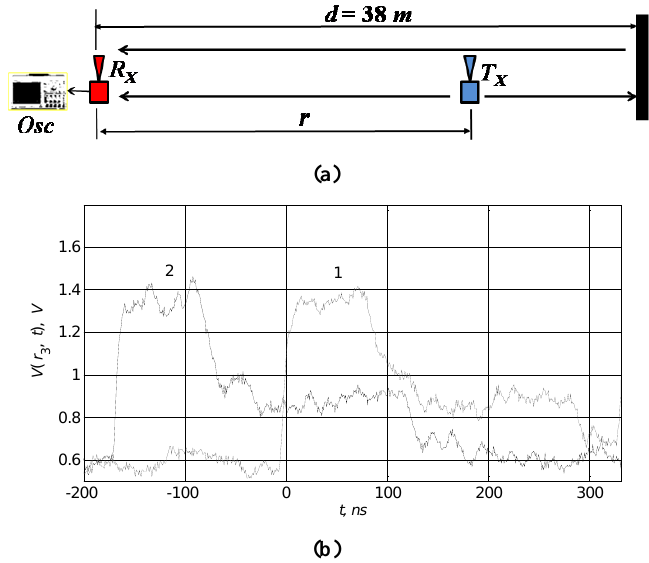
Fig. 1. Measurements of the propagation characteristics: (a) experimental layout. R X – receiver, T X – emitter, Osc – oscilloscope, d = 38 m , r is varied in the range 2 to 32 m; (b) envelopes of chaotic radio pulses V ( r 3 , t ) for r 3 = 8 m illustrating interpulse interference in the receiver: curve 1 is the envelope of the current pulse to be detected, 2 is the envelope of the preceding